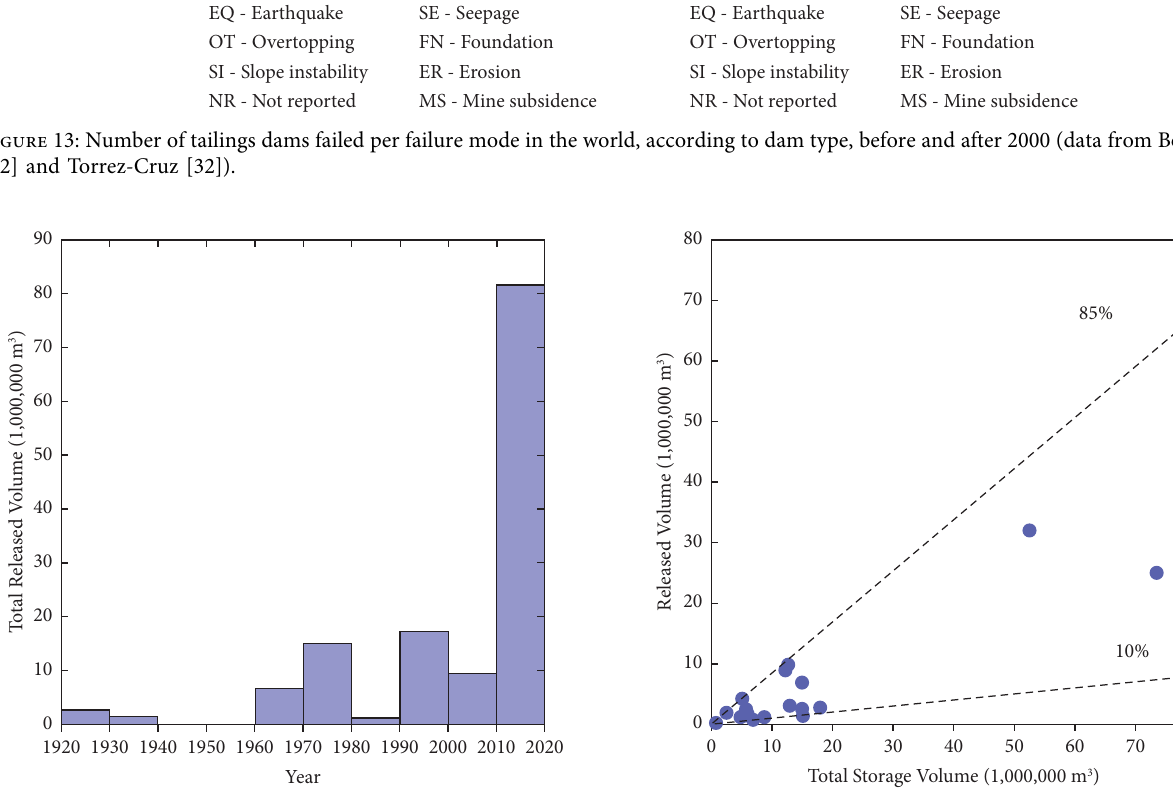
Figure 14: Total released volume of tailings for each decade since 1920 (data from Rana et al. [72]).